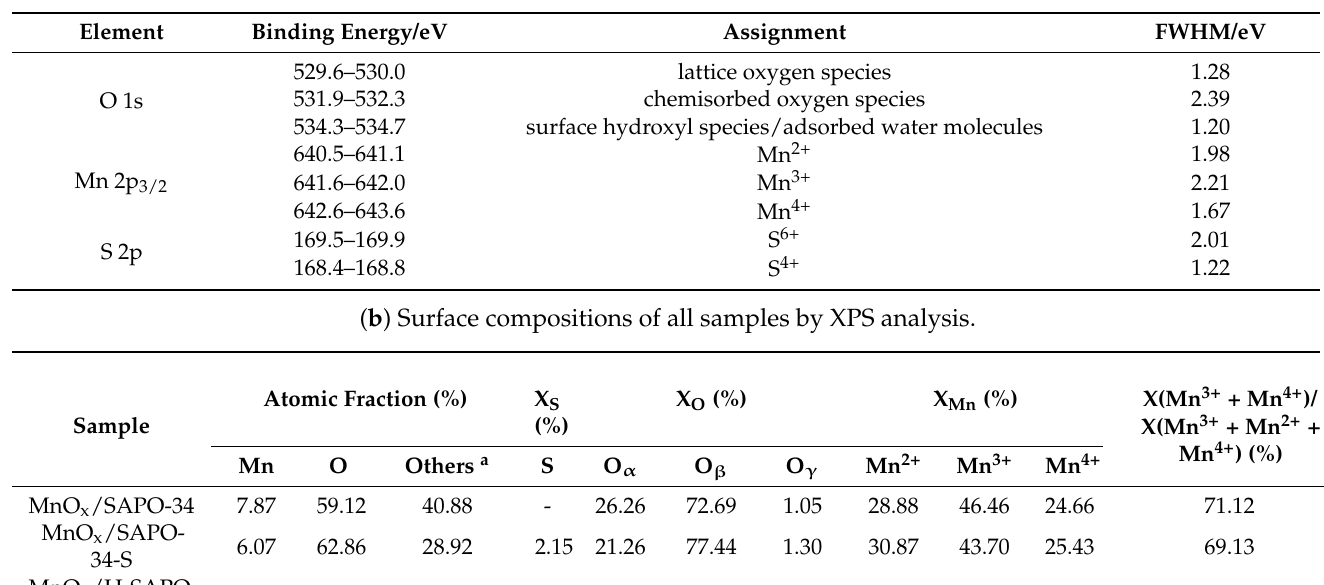
Figure 10. High-resolution XPS spectra of all samples: ( a ) Mn 2p 3/2 , ( b ) O 1 s, ( c ) S 2p. Table 3. ( a ) Assignments of the characteristic peaks in XPS results of fresh and deactivated catalysts.